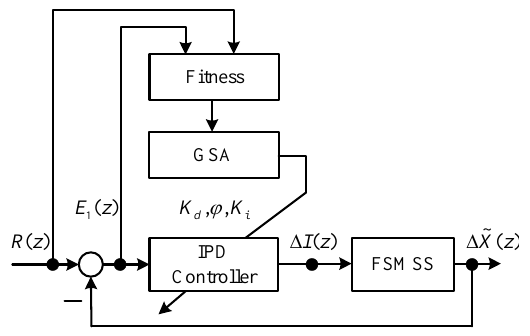
Figure 3. Block diagram of IPD–GSA control of a FSMSS. Table 3. IPD–GSA searching procedure.